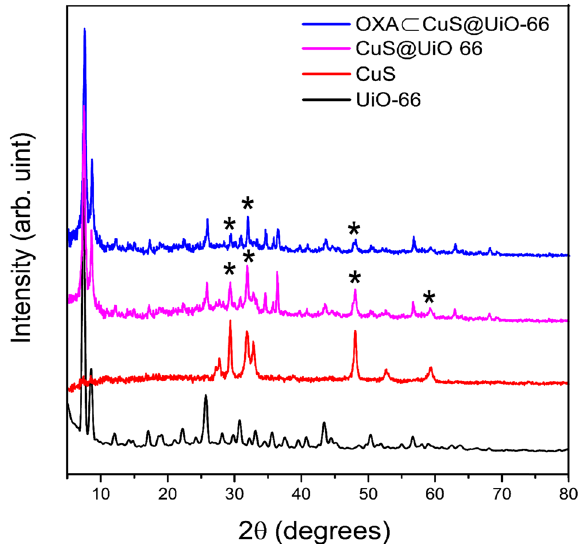
Fig. 1 PXRD of UiO-66-NH 2 , CuS, CuS@UiO-66-NH 2 , and OXA- CuS@UiO-66-NH 2